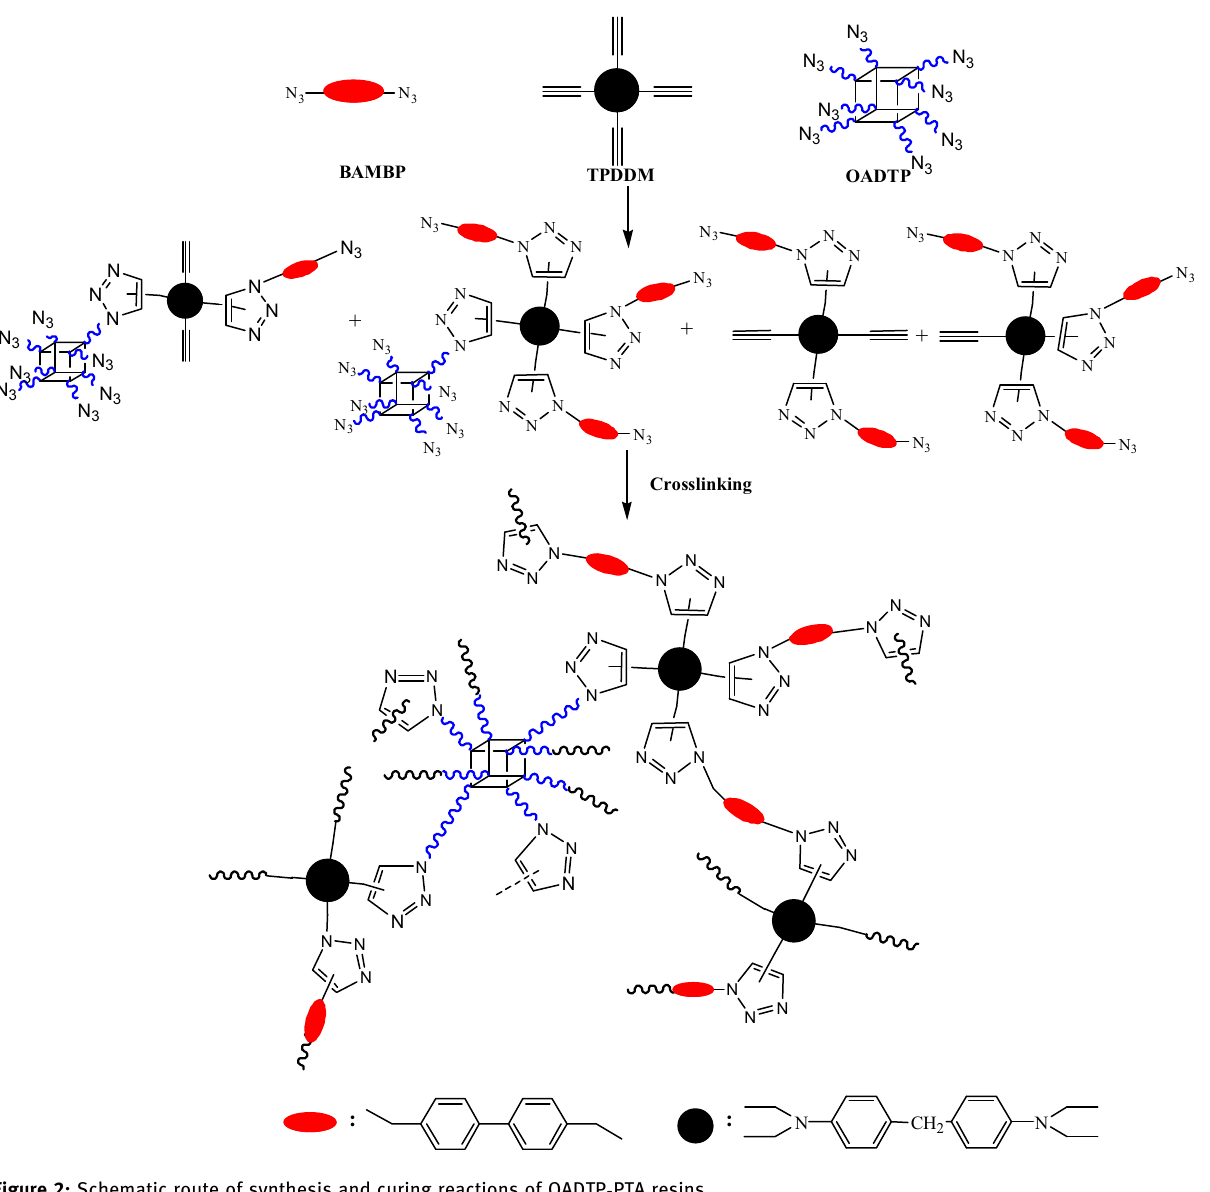
Figure 2: Schematic route of synthesis and curing reactions of OADTP - PTA resins.